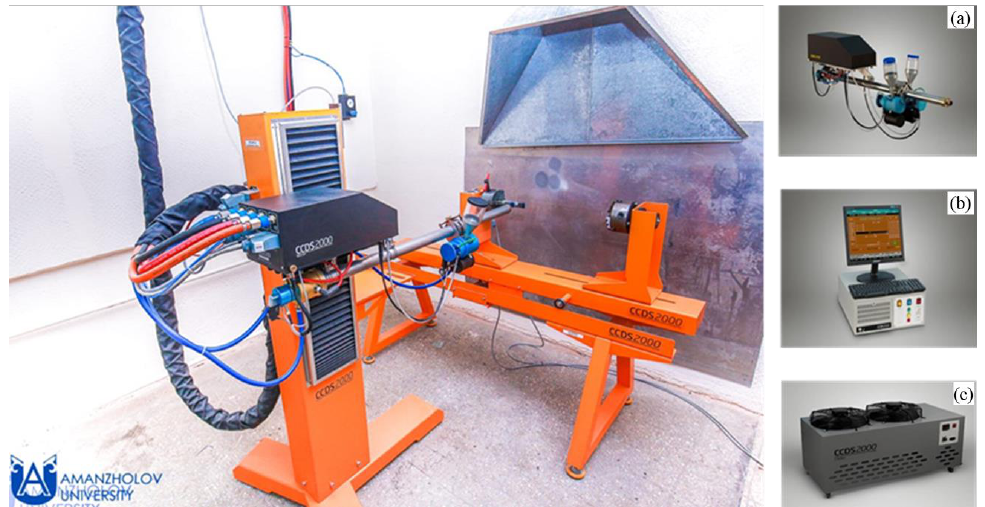
Figure 1. Computerized detonation complex CCDS2000. ( a ) detonation gun; ( b ) control unit and ( c ) cooling system.